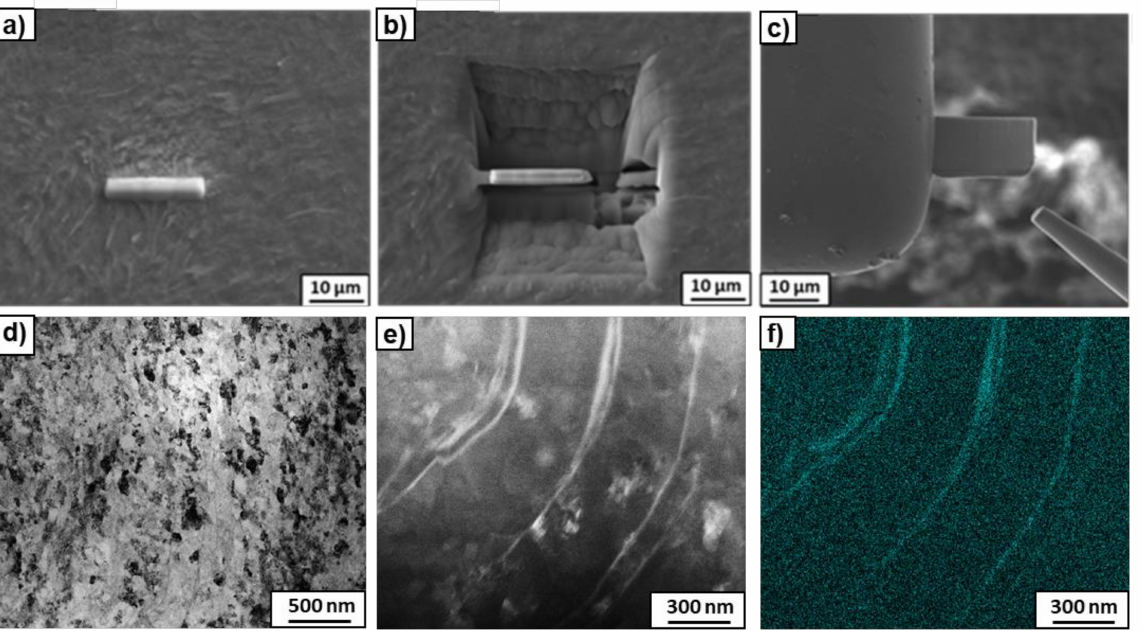
Figure 8. Some stages of thin foil preparation using the FIB method ( a – c ). Bright-field image ( d ), HAADF-STEM image ( e ) of the HPT-deformed Ti–3wt.% Nb alloy, pre-annealed at 600 ◦ C and mapping of Nb element ( f